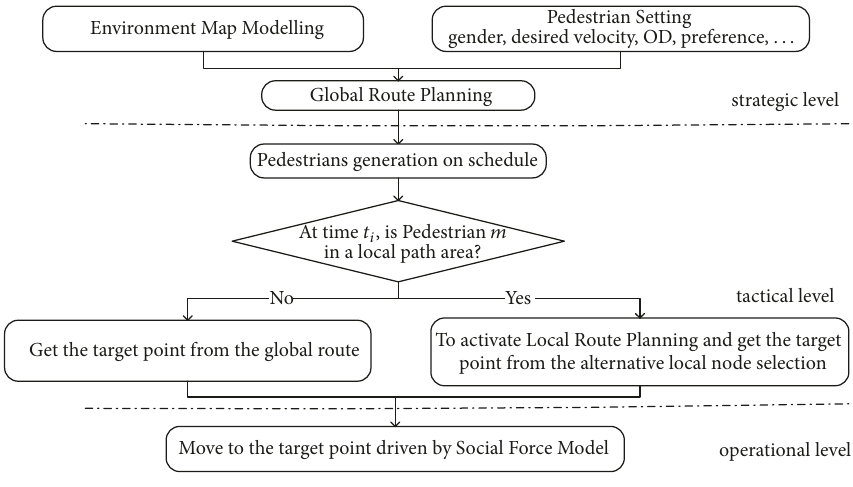
Figure 3: The framework of the layered navigation algorithm.